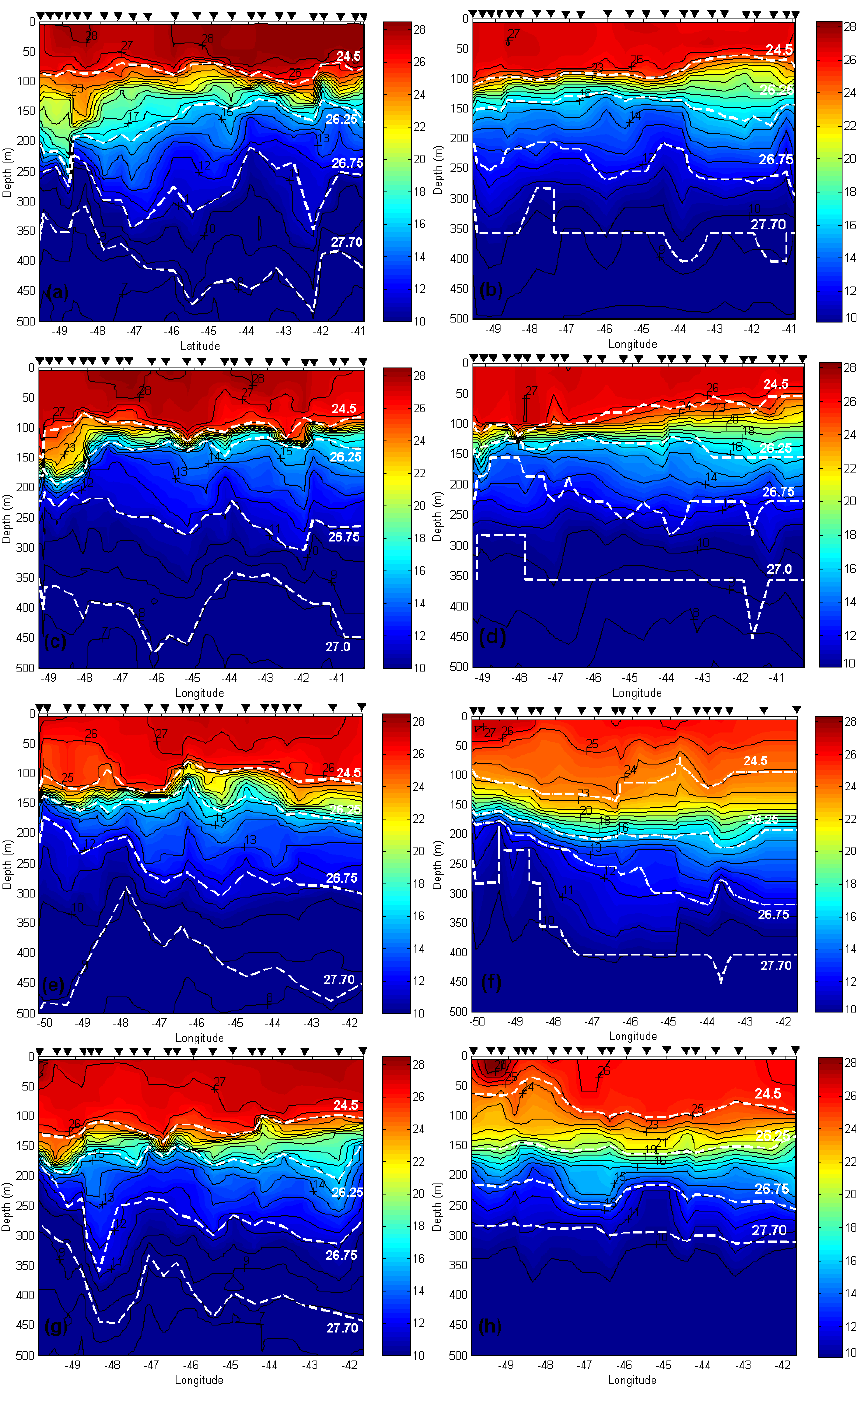
Fig. 2. Vertical distribution of temperature from the surface down to 500m depth along transects almost parallel to the coast is indicated by a solid straight gray line (see Fig. 1) during REVIZEE cruises from field data and CLIPPER model results: (a) hydrographic data for March–May 1995, (b) model results for March–May 1995, (c) hydrographic data for May–June 1999, (d) model results for May–June 1999, (e) hydrographic data for July–August 2001, (f) model results for July–August 2001, (g) hydrographic data for October–November 1997 and (h) model results for October–November 1997. The superimposed dashed lines (white) indicate the depth of the σ θ =24.5, 26.25, 26.75 and 27.70kgm − 3 . In the left panels, inverted (black) triangles represent the location of hydrological stations during the cruises. In the right panels, the same triangles represent the selected numerical model grid nodes coincident with the cruise hydrological